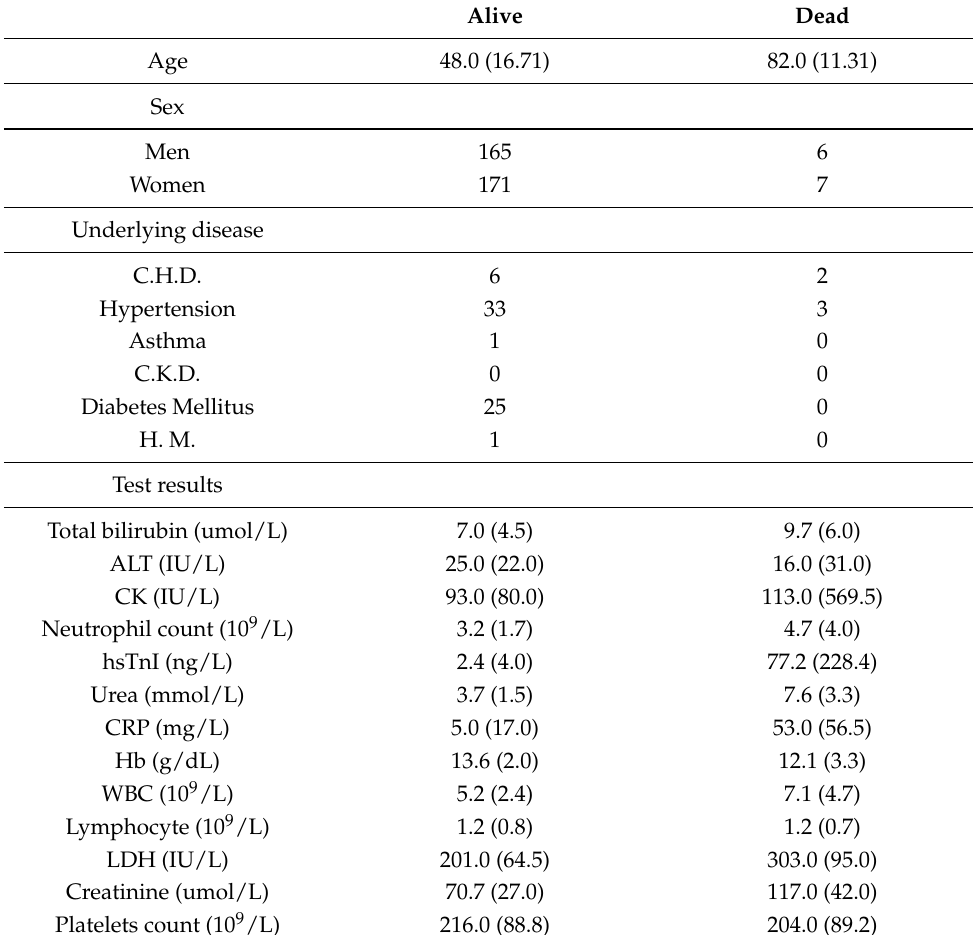
Table 1. The distribution of various features according to the binary patient outcome class Mortality. The number of patient comorbidities in each class is indicated as such (C.H.D: chronic heart disease; the interquartile range in parentheses are presented for each class (ALT: alanine aminotransferase, CK: creatine kinase, hsTnI: high sensitivity troponin I, CRP: C-reactive protein, Hb: hemoglobin. WBC: total white blood cell count, LDH: lactate dehydrogenase).